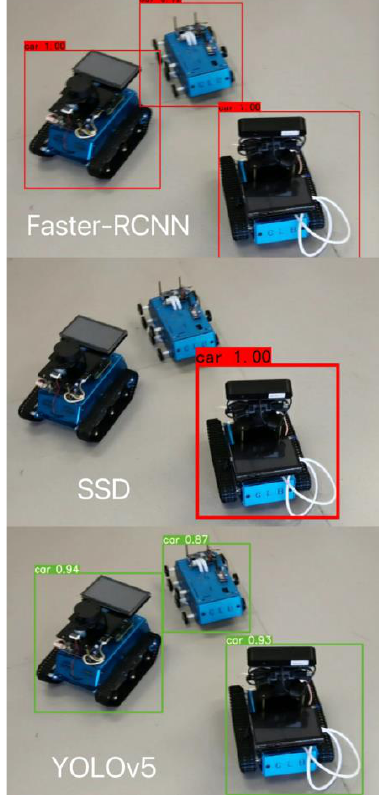
Figure 8. Three models’ testing results in the same frame.